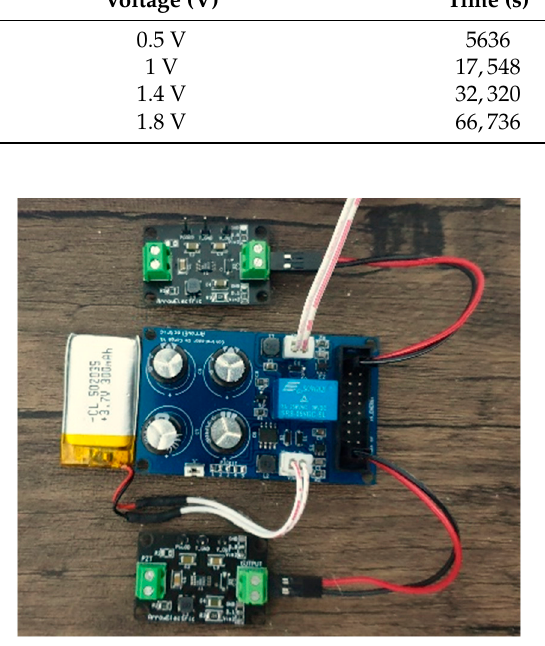
Figure 14. Way of connecting two energy harvesting modules to the energy management card.